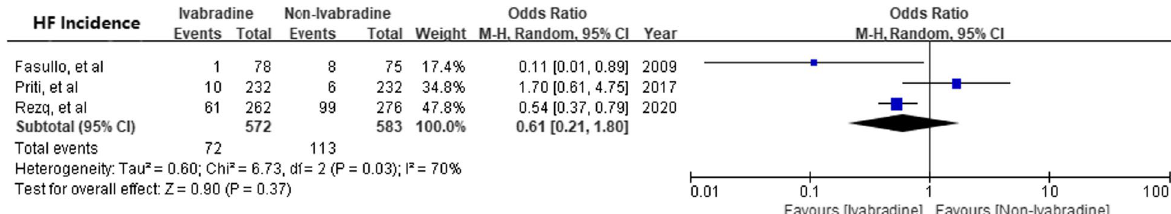
Fig. 5 Effect of Ivabradine on Heart Failure Incidence